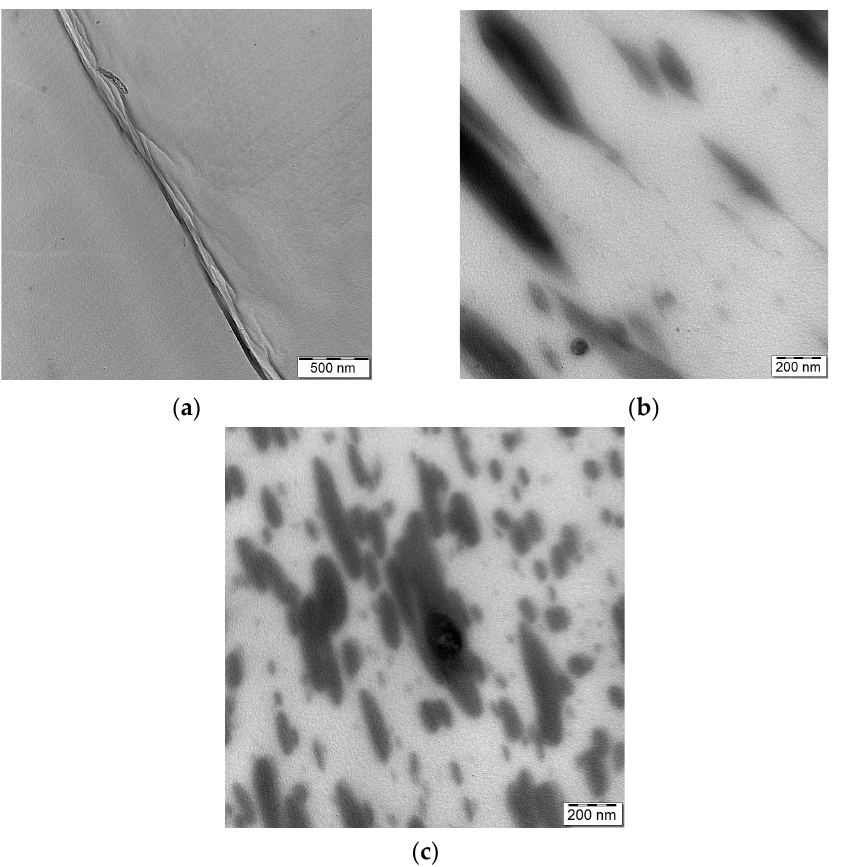
Figure 1. TEM images of fibrous ordered structure of CNCd ( a ) in PLA, and ( b ) in 80/20 PLA/PCL (with PLA/CNCd pre-blend); ( c ) TEM image of 80/20 PLA/PCL (prepared using PCL/CNCd mas- terbatch).